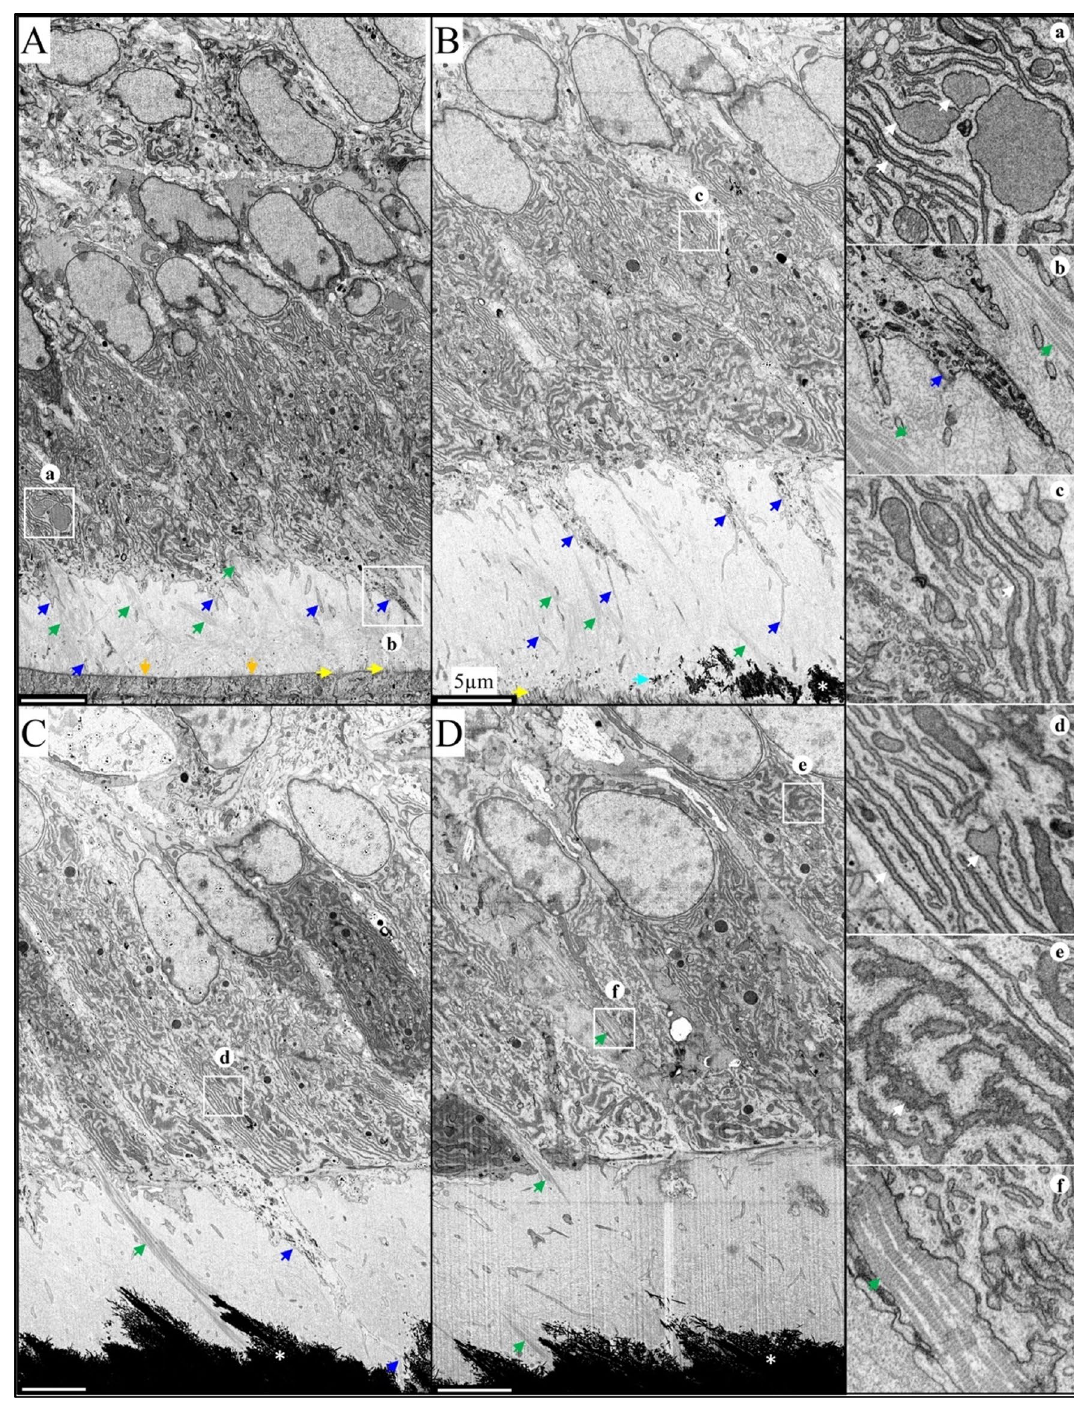
Figure 1. FIB-SEM of a 7-week-old Wild Type Incisor Showing Normal Odontoblast Morphology and Dentin Formation. ( A – D ). 5000 × FIB-SEM montages from areas -2 (A), 0 (B), S1 (C), and S2 (D) from Fig S1. ( a – f ). 10,000 × FIB-SEM insets of boxed areas. ( A ) The basement membrane separating ameloblasts from pre-dentin (orange arrows) is gradually degraded and penetrated by cell protrusions (yellow arrows). Note the polarized odontoblasts with odontoblastic processes (blue arrows) and collagen bundles (green arrows) between odontoblasts and in pre-dentin. ( a ) Regular and enlarged ER cisternae (white arrows) with clear membrane boundary. ( b ) Odontoblastic process (blue arrow) surrounded by matrix rich in collagen bundles (green arrows). ( B ) Dentin mineral foci (cyan arrow) in pre-dentin coalesce into a continuous layer of dentin (*). ( c ) Parallel ER cisternae (white arrow) and Golgi apparatus. ( C ) Collagen bundle spanning pre-dentin is mineralized in dentin (*). An odontoblastic process branches and extends into mineralized dentin (blue arrow). ( d ) Stacks of ER (white arrow). ( D ) Collagen bundles (green arrows) between odontoblasts. ( e ) ER (white arrow) with rough border near nucleus. ( f ) Banded collagen bundles (green arrow) between odontoblasts. Scale bars: 5